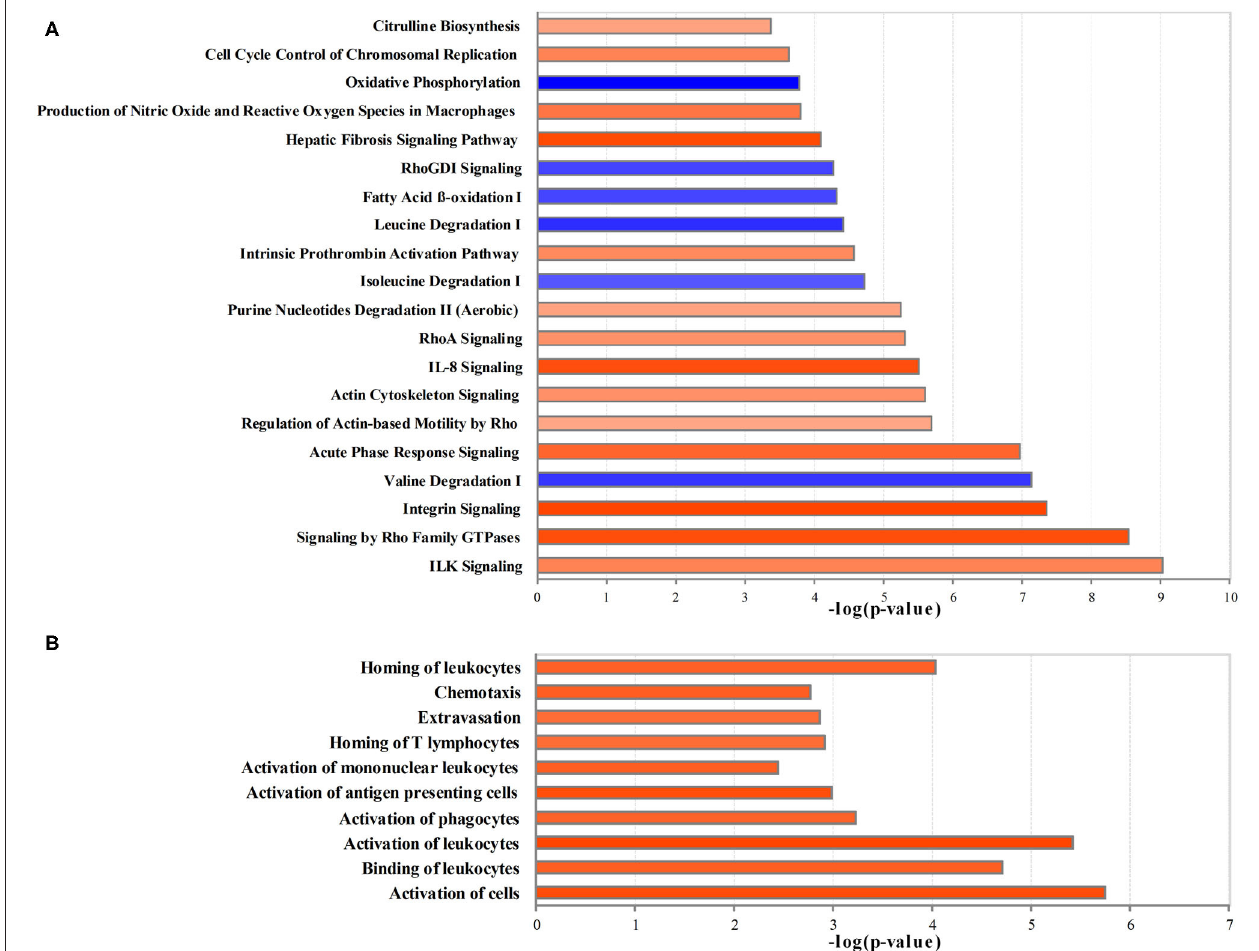
FIGURE 3 | The creditable canonical pathways and disease or functional annotation based on the differentially expressed proteins and metabolites (| z -score > 2| and p < 0.05). (A) Canonical pathways. (B) Disease or functional annotation. Orange represents activation ( z -score > 2); blue represents inhibition ( z -score < − 2), and the darker color represents a more significant activation or